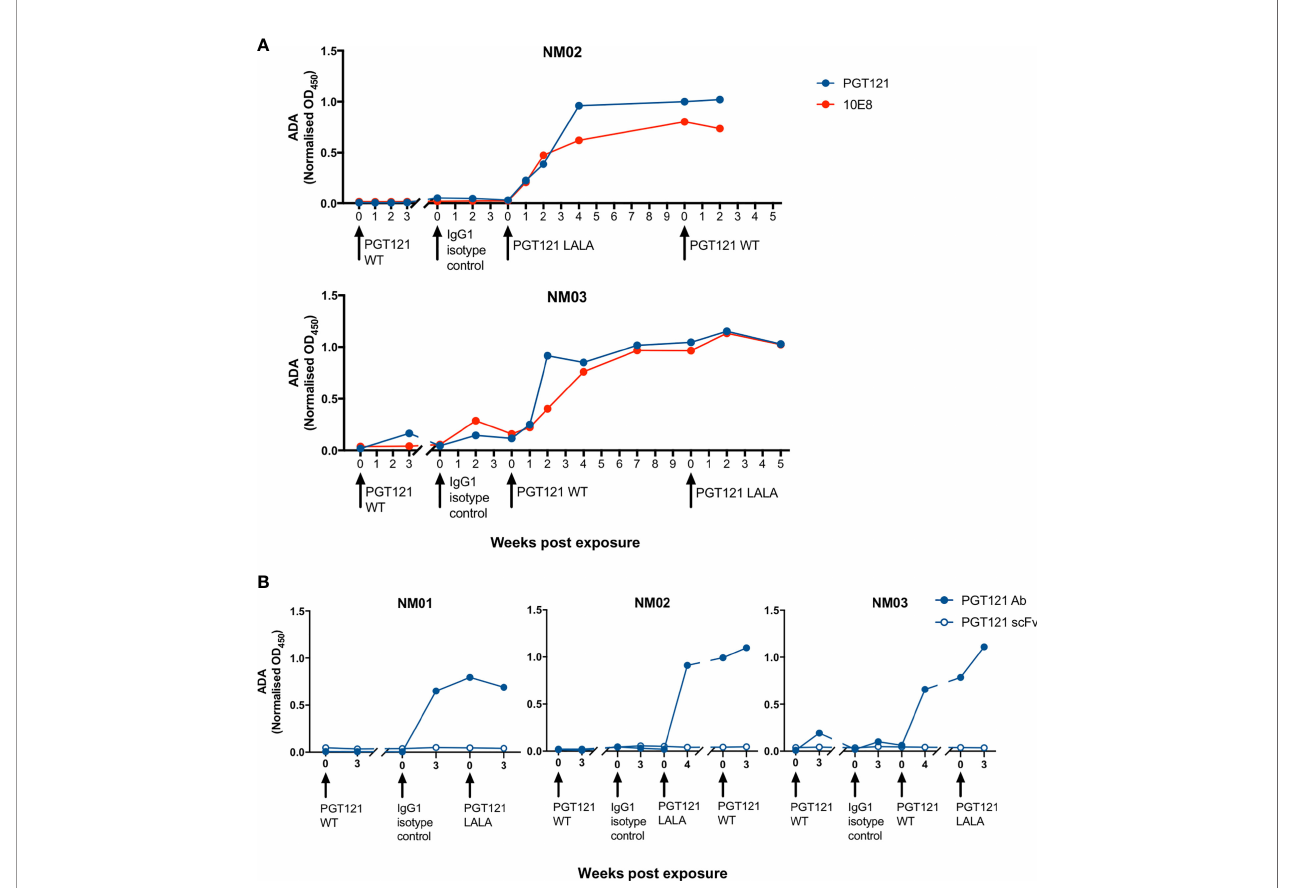
FIGURE 5 | The speci fi city of ADA responses in pigtailed macaques following multiple infusions of human antibodies. (A) Macaque anti-PGT121 and anti-10E8 ADA are shown in blue and red respectively. (B) The level of macaque ADA against full length PGT121 (closed circles) and PGT121 scFv (open circles). Black arrows indicate antibody